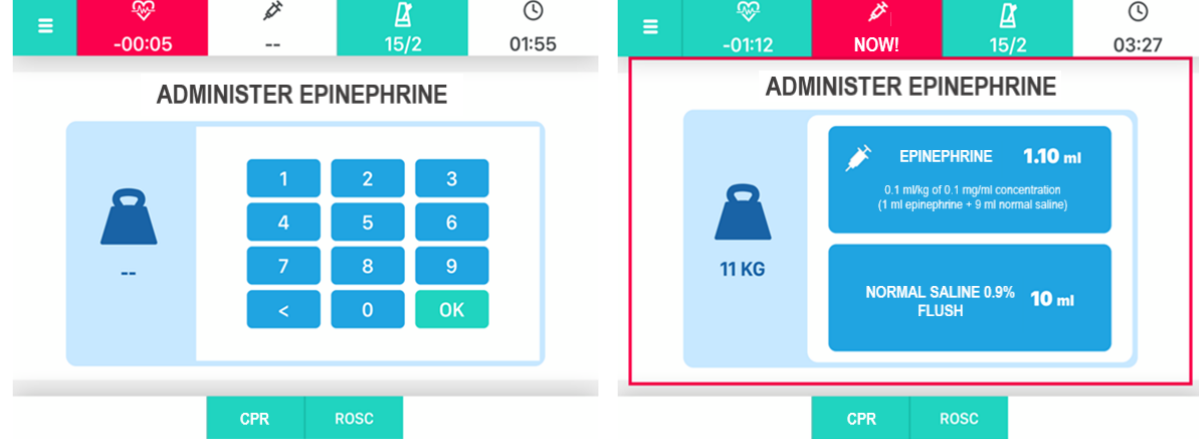
Figure 4. Epinephrine administration screens. CPR: cardiopulmonary resuscitation; ROSC: return of spontaneous